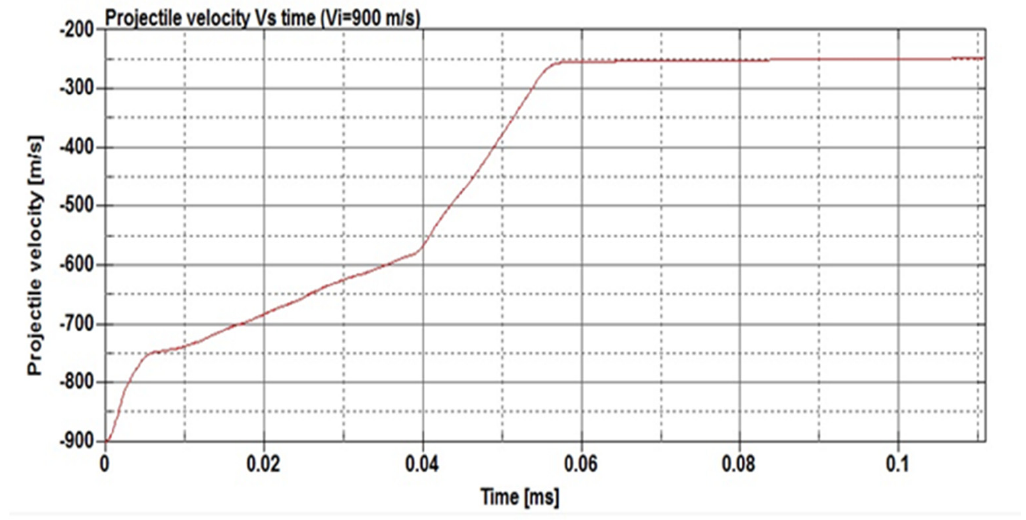
Figure 13. Structure deformation at different timings, Vi = 875 m/s.